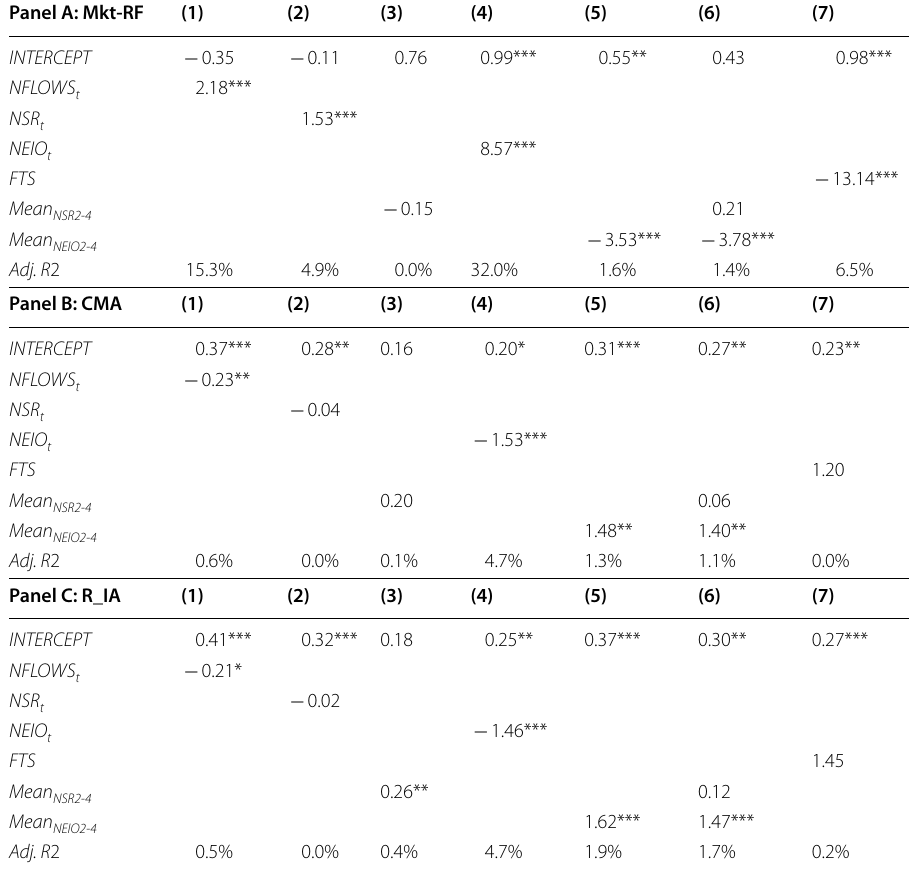
Table 2 Regression of factor portfolio returns on flows and